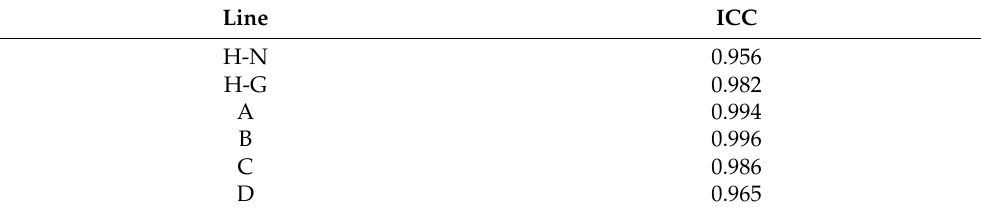
Table 1. Intraclass correlation coefficient by variable reference lines.